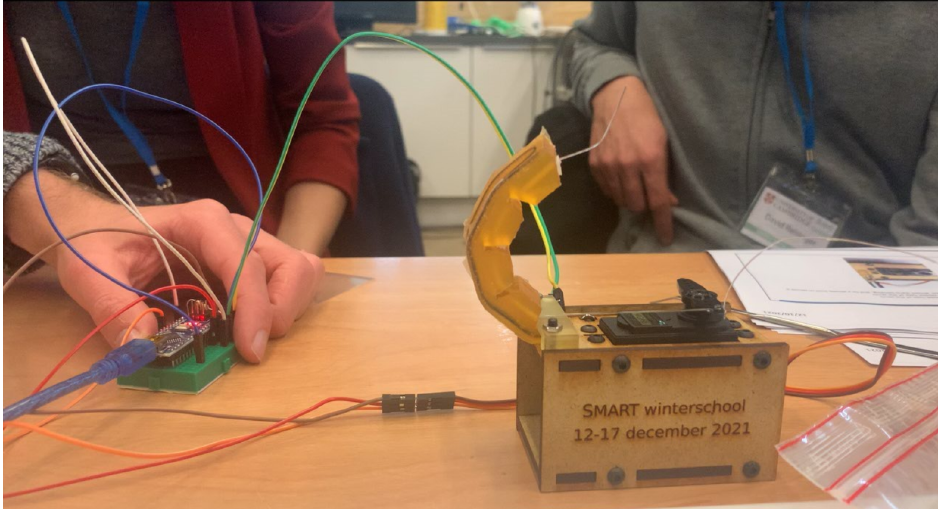
Figure 6. Participants testing the set-up. Participants successfully built the set-up and are actuating the finger while recording the strain sensor values on their